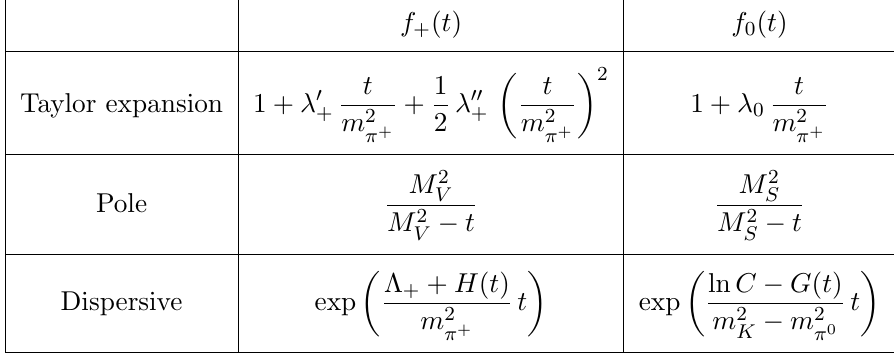
Table 1 . Form factor parameterizations used in this analysis. The free parameters to be measured are the (cid:21) 0 , (cid:21) 00 , (cid:21) 0 coe(cid:14)cients (slopes) for the Taylor expansion, the scalar M S and vector M V + + mass values for the pole model, and the (cid:3) + and ln C parameters for the dispersive